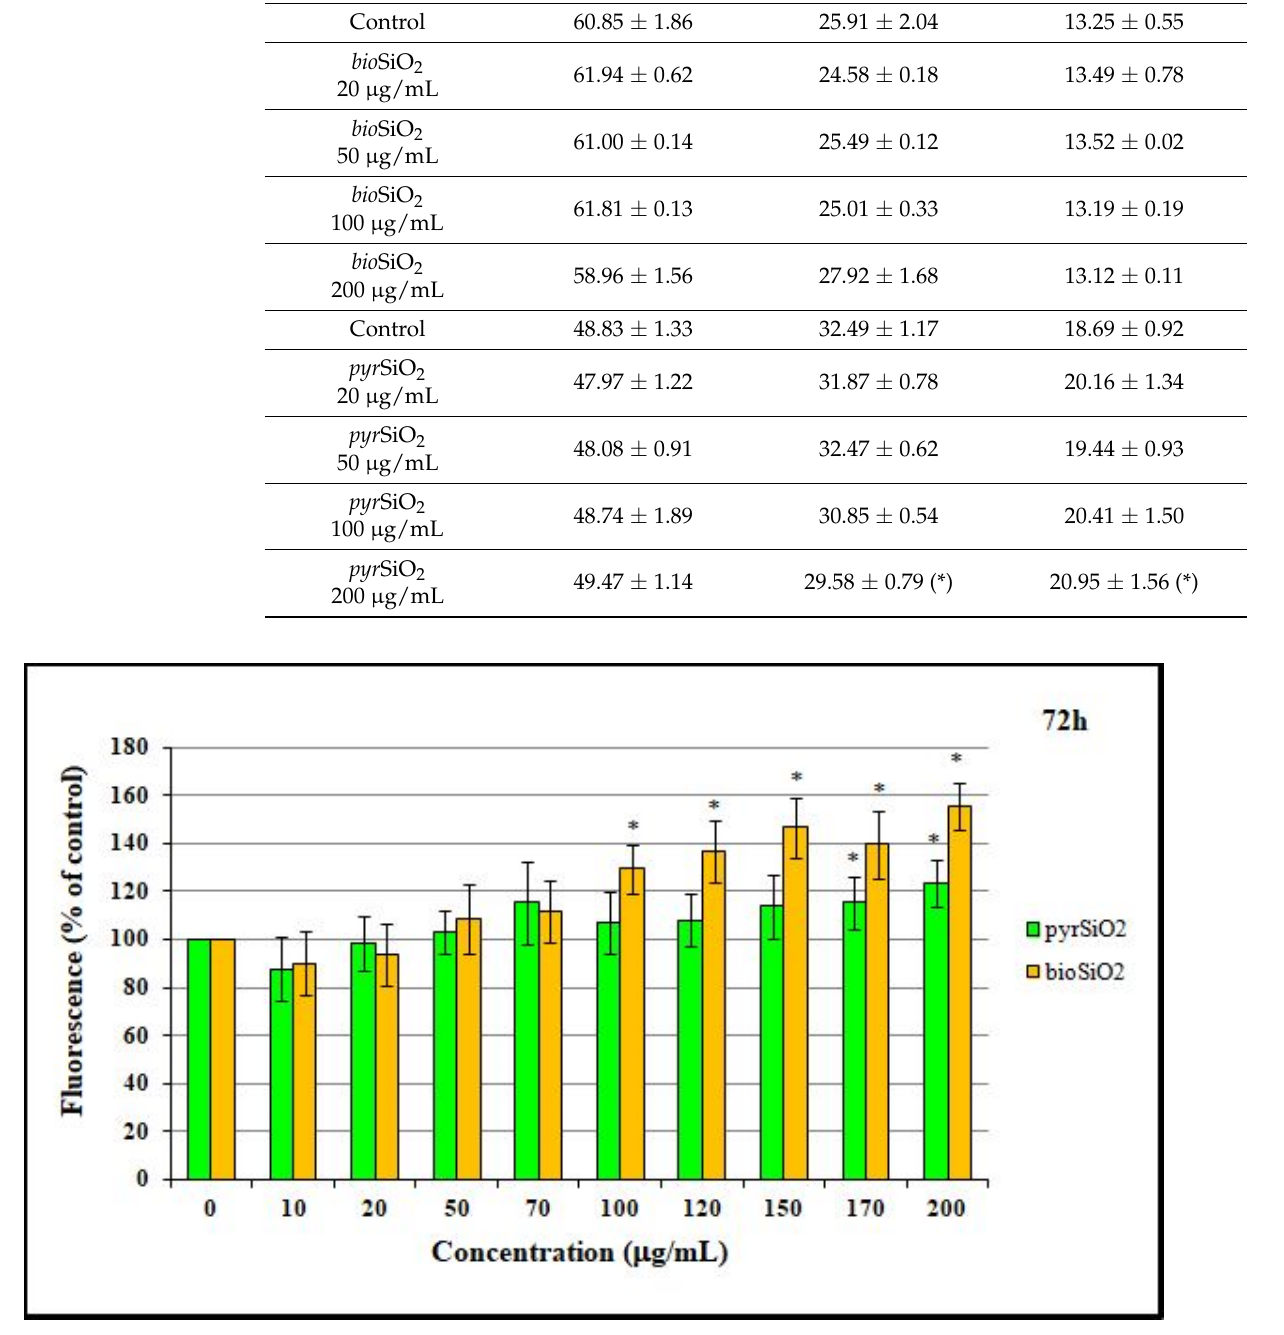
Figure 9. Intracellular reactive nitrogen species (RNS) generation in HMEC-1 cells. Production of RNS of human dermal microvascular endothelial cell line after treatment of silica nanoparticles (pyrogenic and biogenic). Statistical evaluation of differences was conducted using the ANOVA I and Tukey’s post hoc tests, at significance levels of p < 0.01 (*) with respect to the control.